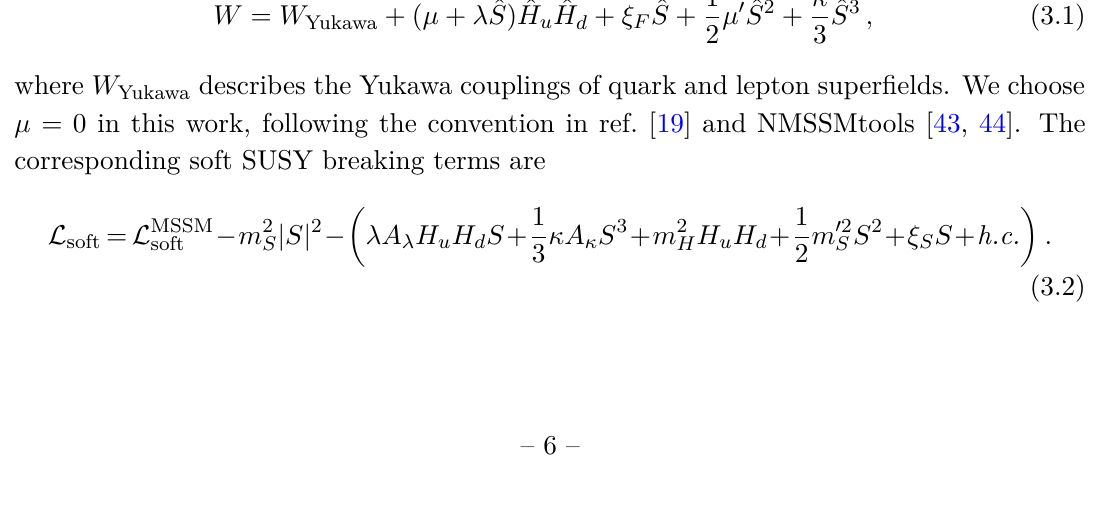
Figure 1 . The transfer cross section σ T ( × k 2 / (4 π ) ), the symmetric viscosity cross section σ VS ( × k 2 / (4 π ) ) and the asymmetric viscosity cross section σ lated by eq. (2.25) (upper panels) and calculated by numerically solving the Schrödinger equation (low